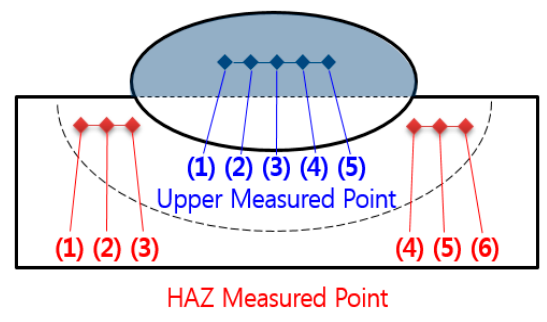
Figure 3. Vickers hardness tester.